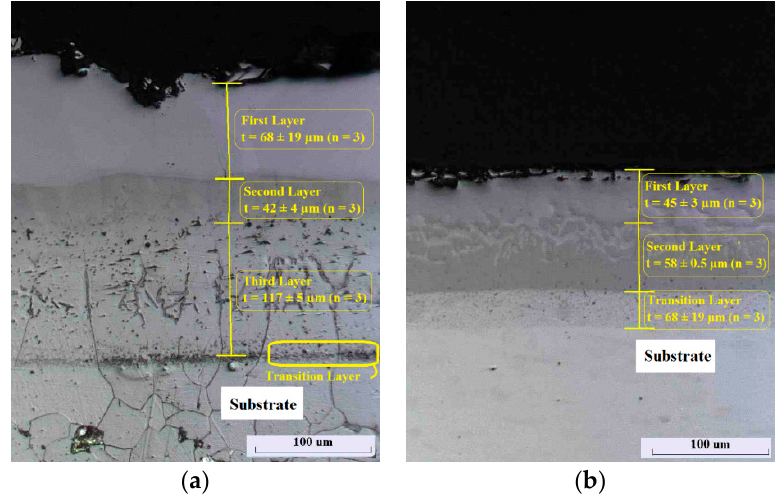
Figure 1. Microstructure image of aluminized ( a ) low carbon steel, and ( b ) 316 stainless steel.